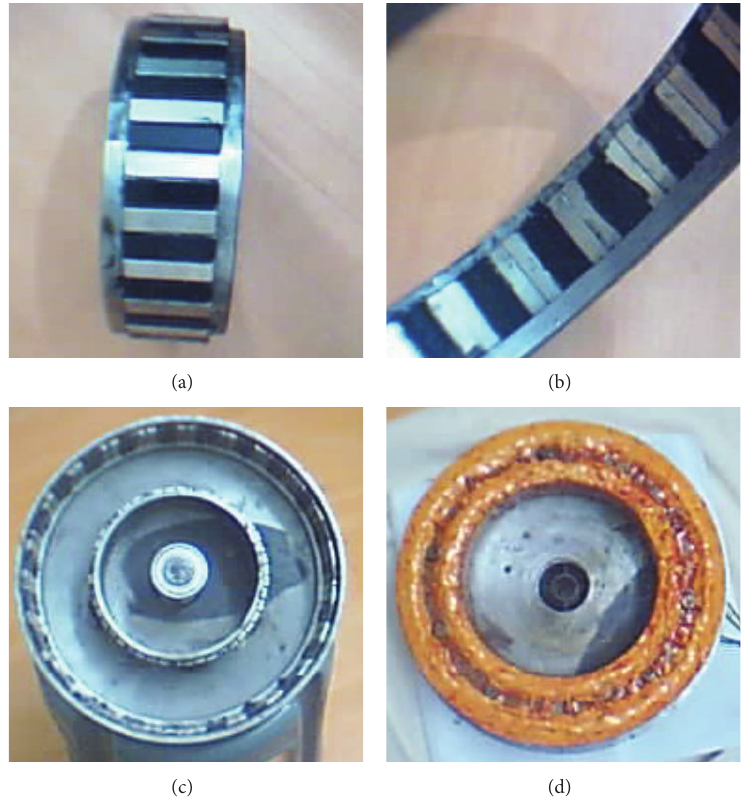
Figure 13: Rotors and stator of DRPMG prototype.